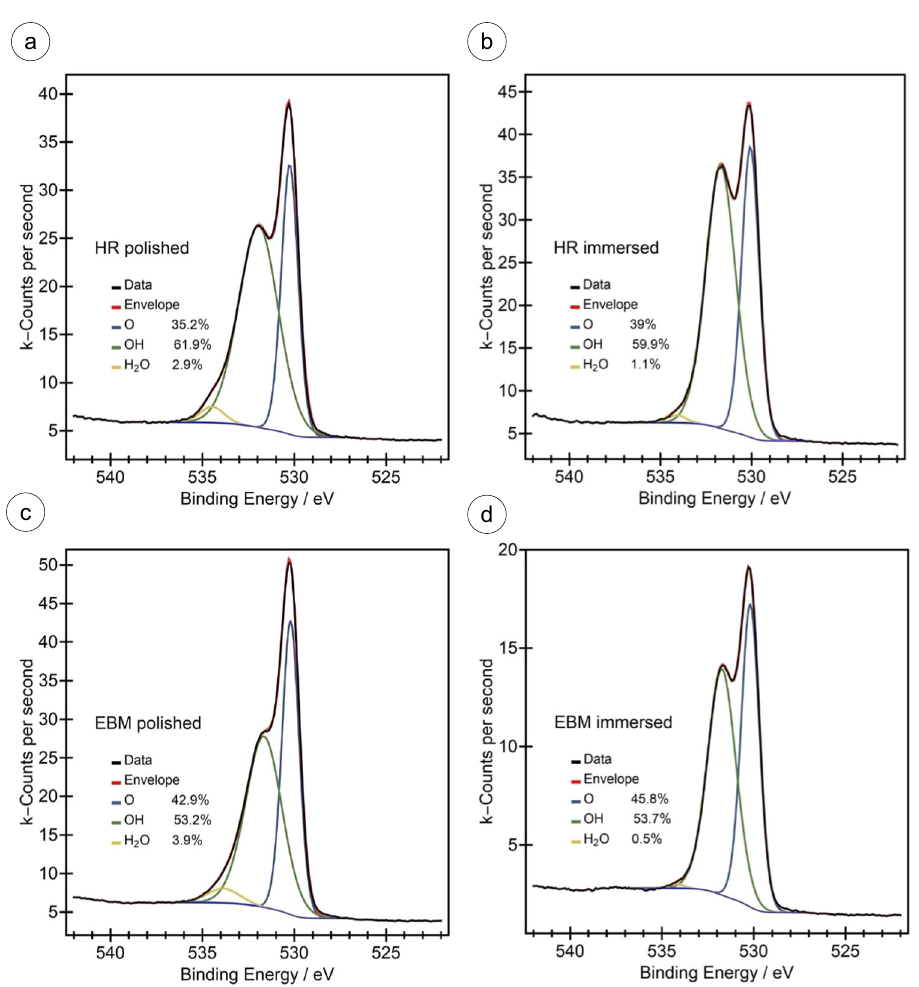
Fig. 13 O1 s element spectra of as-prepared (polished, etched) samples in comparison to the surface states after 24-h immersion in m-SBF. Shown for a , b HR iron and c , d EBM iron.